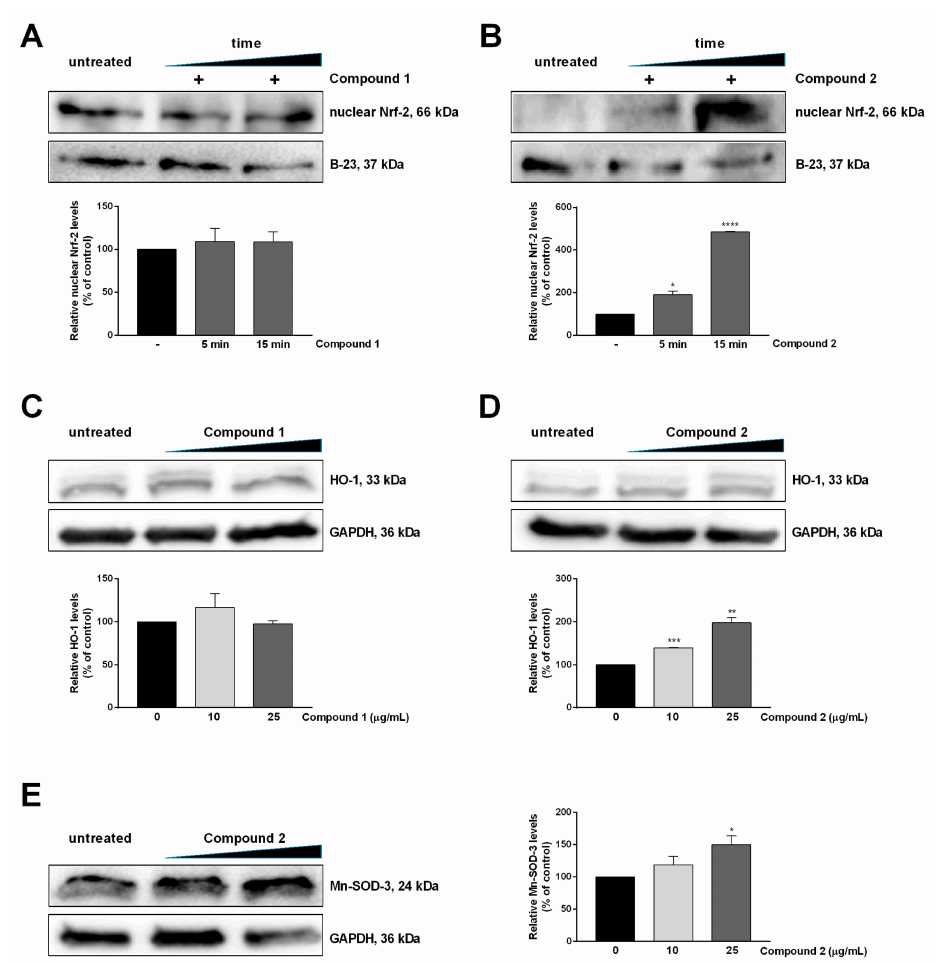
Figure 4. Mechanisms of action of isolated compounds. A , B : Nuclear transcription factor-2 (Nrf-2) levels were analyzed by Western blot. Keratinocytes were incubated with increasing concentrations of compound 1 ( A ) or compound 2 ( B ) for 5 min or 15 min and then lysed. The relative changes in Nrf-2 levels were quantified densitometrically; B-23 was used as a loading control. C , D : Western blot analysis for HO-1. E : Western blot analysis for Mn-SOD-3 of cells incubated with compound 1 . HO-1 and Mn-SOD-3 levels were quantified by densitometric analysis and normalized to GAPDH. Data shown are the means ± S.D. of three independent experiments. * indicates p < 0.05, ** indicates p < 0.01, *** indicates p < 0.001, **** indicates p < 0.0001, with respect to control